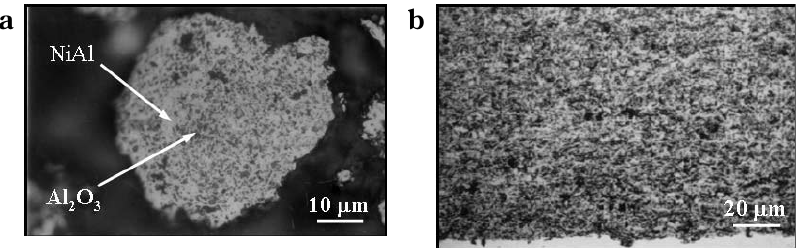
Fig.11 Cross-sections of NiAl / Al 2 O 3 powder (a) and high-velocity plasma spray coating from it (b).